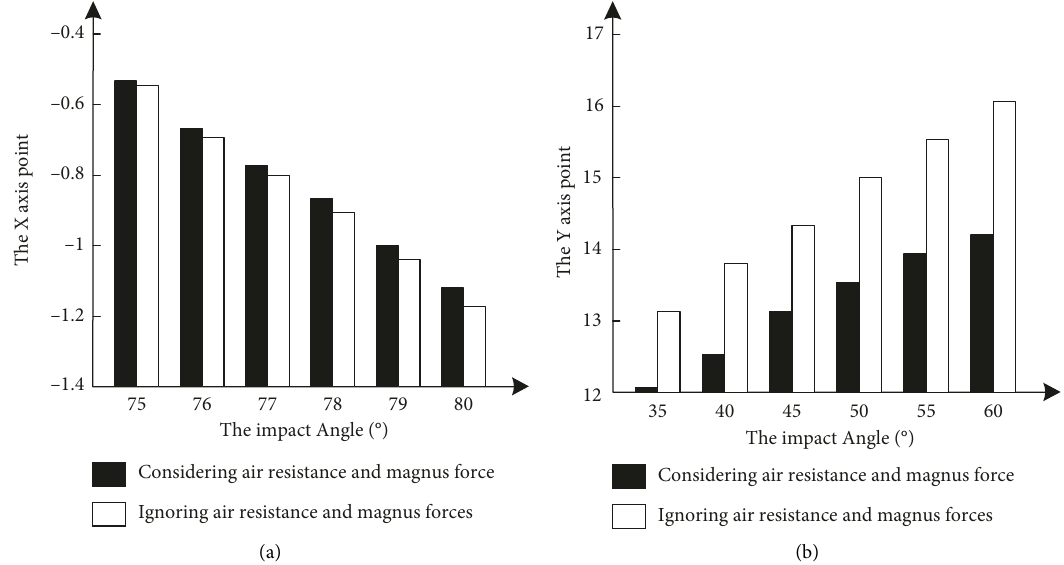
Figure 7: Relationship between the impact angle and the coordinates of its landing point: (a) x -coordinate and (b) y -coordinate.